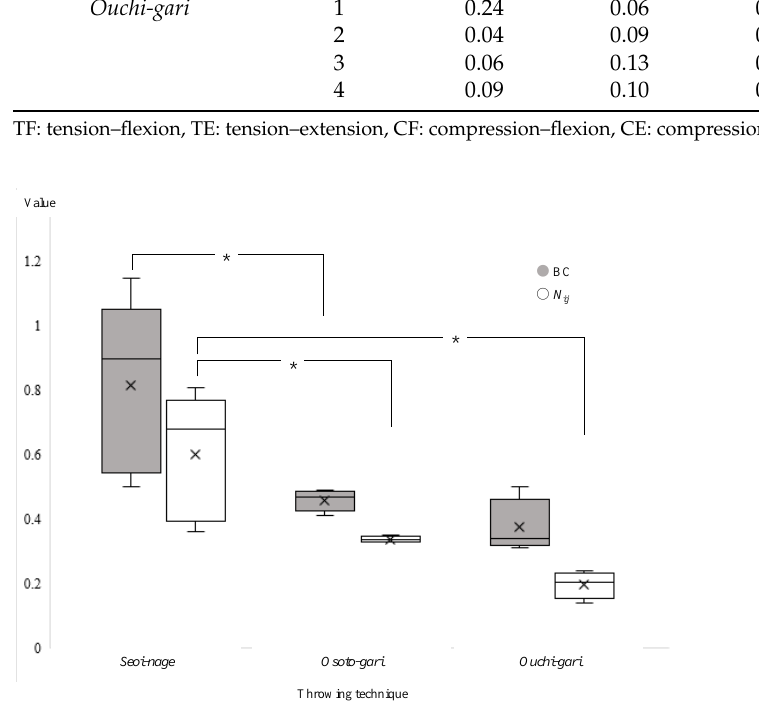
Figure 3. Comparison of neck injury criterion ( N ij ) and beam criterion (BC) values among the three throwing techniques. Statistical significance: * p < 0.05; Steel-Dwass method.